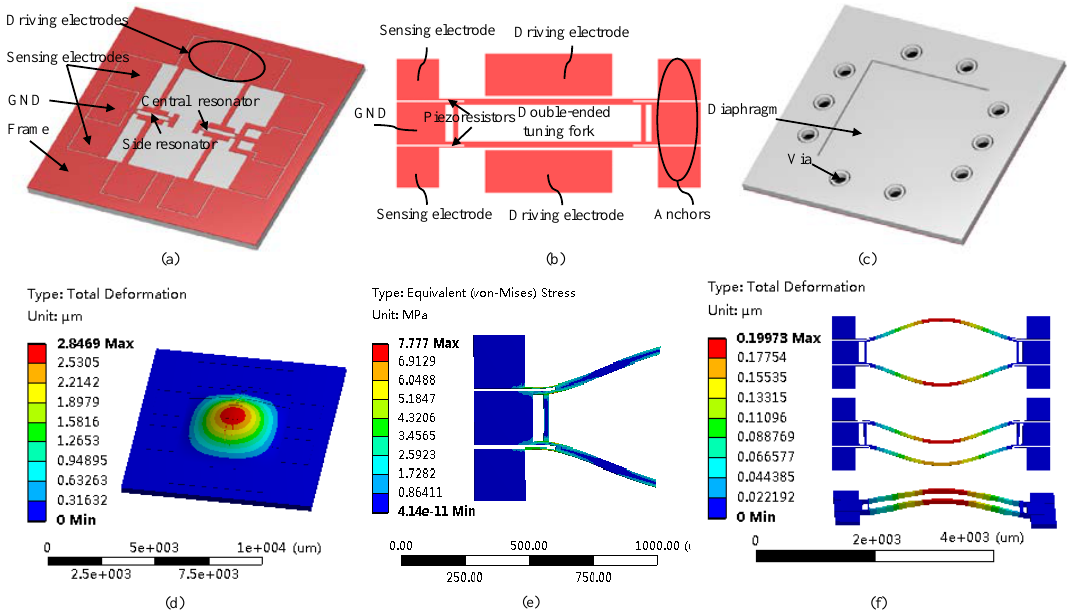
Figure 1. Schematic and working principle of the resonant pressure microsensor relying on electrostatic excitation and piezoresistive detection ( a ) where double-ended tuning forks ( b ) were used as resonators. In addition, the through-silicon vias surrounding the pressure sensitive membrane ( c ) were adopted in annular shapes for electrical isolation. Pressures under measurement cause the deformations of the pressure sensitive membrane ( d ) leading to stress buildups of the resonators ( e ) with corresponding shift of the resonant frequency. The first three resonant modes of the microsensor were illustrated in ( f ) with corresponding resonant frequencies of 89.4 kHz, 89.8 kHz and 121.1 kHz respectively. Note that (1) a differential design was adopted in this study, which can further increase the sensitivity and linearity of the pressure sensor and (2) the results of numerical simulations for ( d – f ) were not to scale.